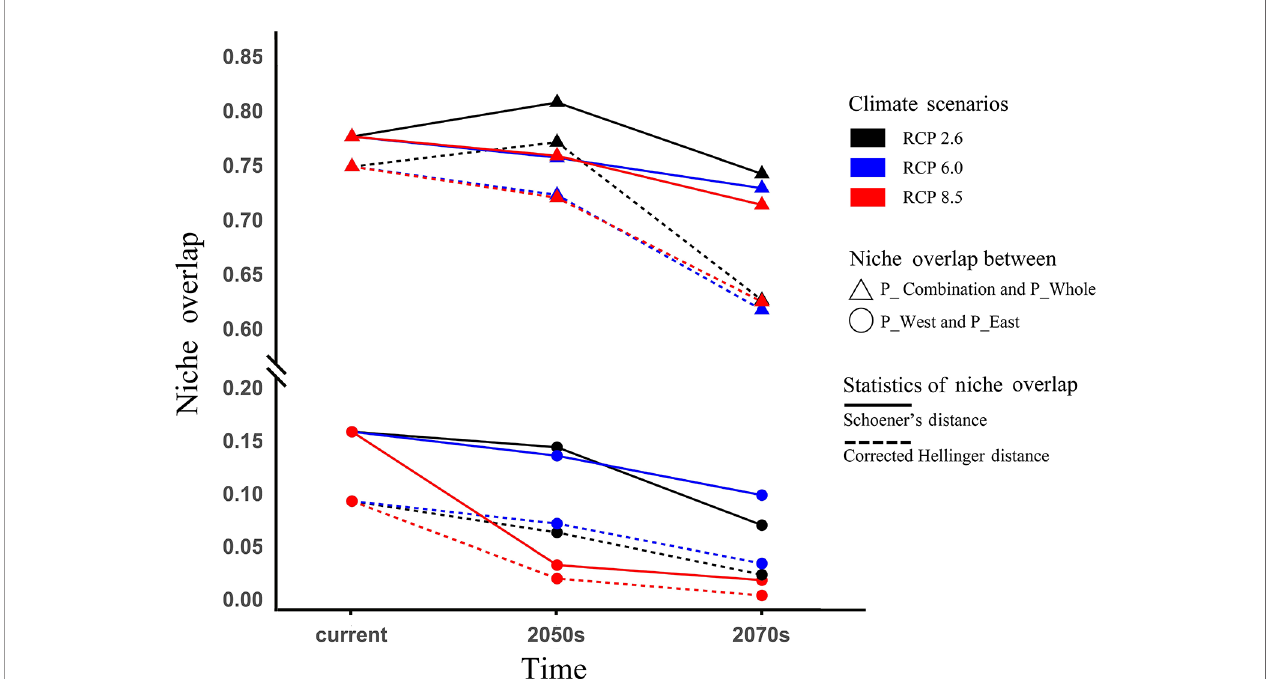
FIGURE 9 | Niche overlap and changes under climate change. Niche overlap was measured by Schoener's D values and corrected modi fi ed Hellinger distance, both ranging from 0 (refers to populations with completely discordant niches) to 1 (refers to populations with identical